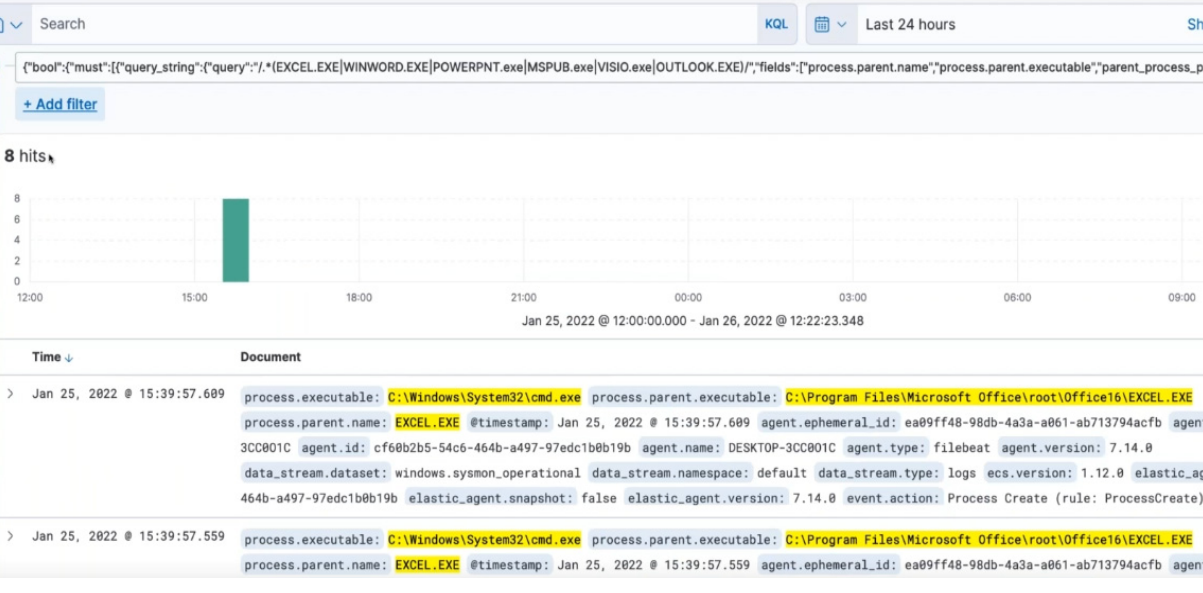
Figure 6. Script reported threat activities.